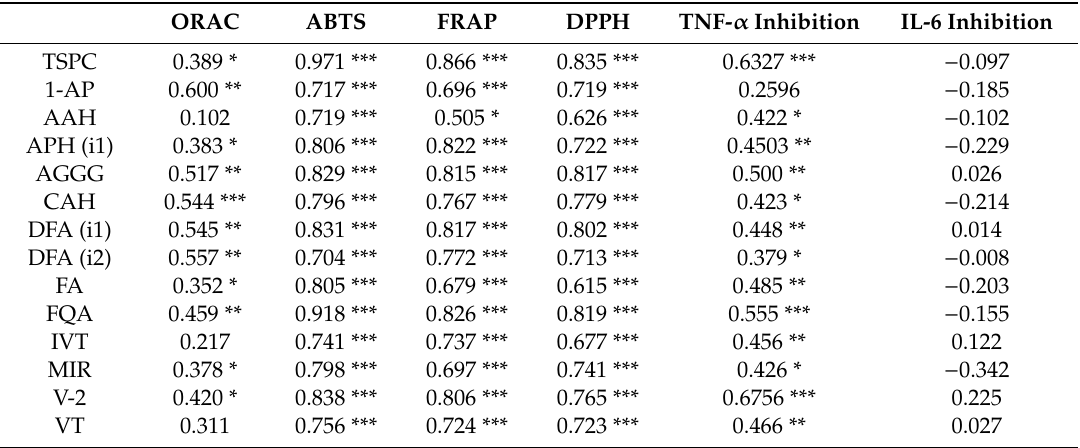
VT 0.311 0.756 *** 0.724 *** 0.723 *** 0.466 **